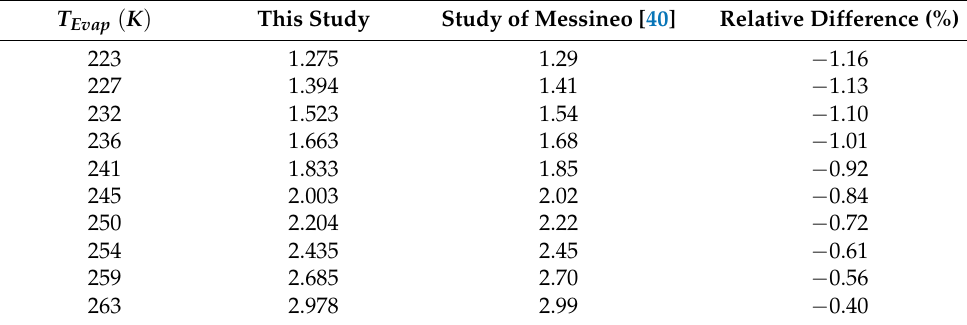
Table 4. Validation results in terms of COP for different T Evap values.